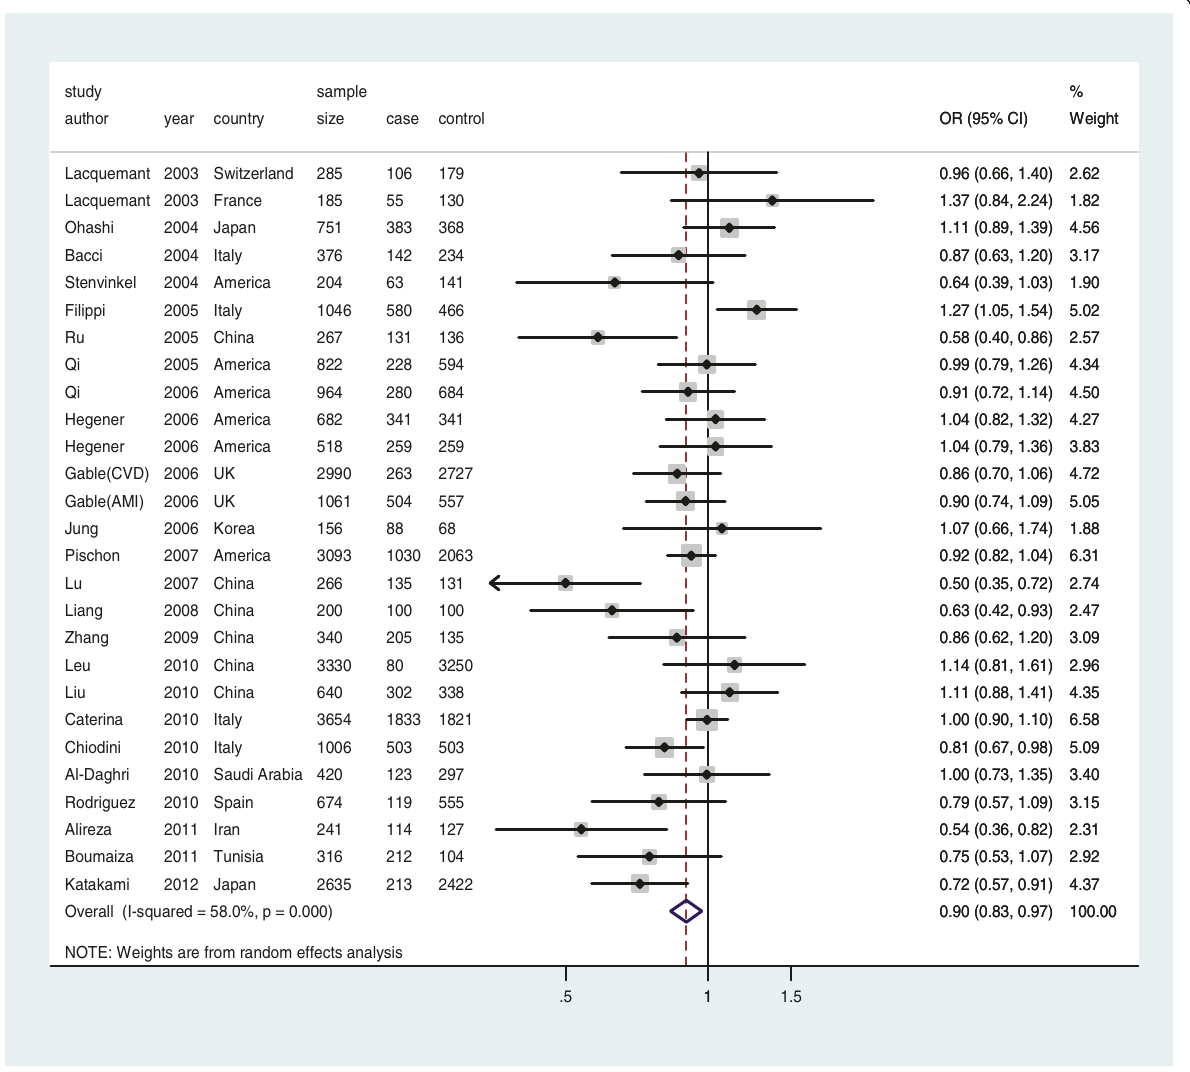
Figure 3 Meta-analysis for the relationship between rs1501299 and CVD risk. Year represents publish year. The solid squares represent odds ratios (ORs) from individual studies; the diamonds are shown as overall effect. The combined ORs along with their 95% CIs were in the contrast of T allele vs. G allele and estimated using the fixed-effects